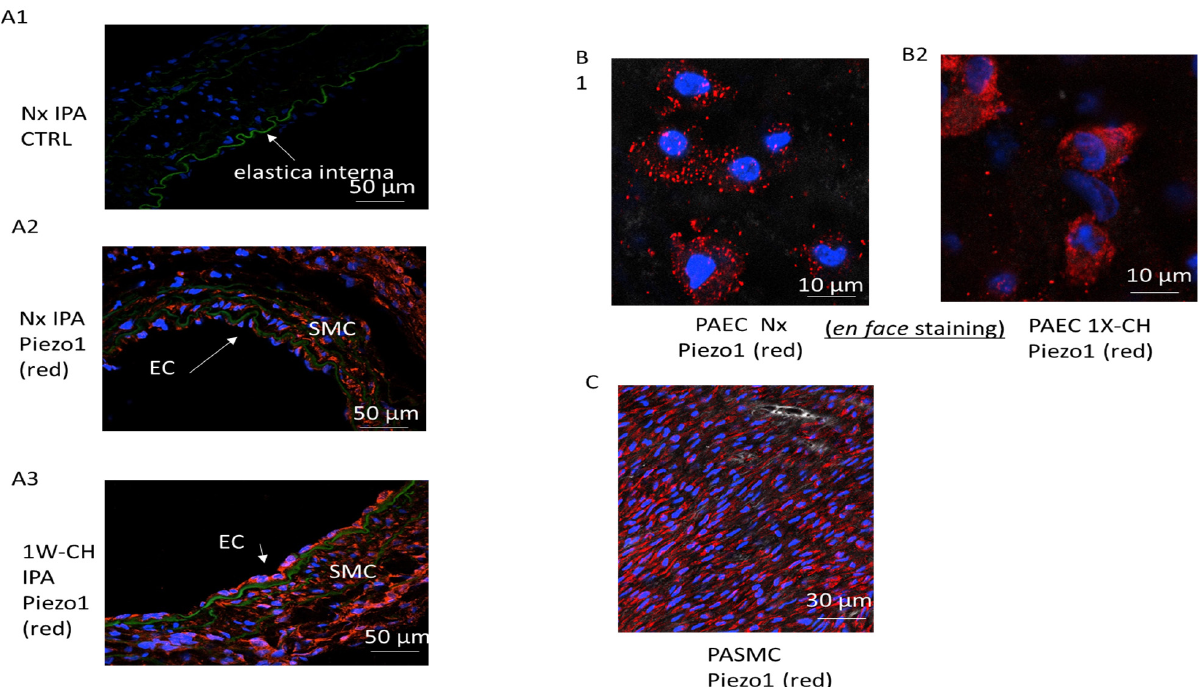
Figure 2. Piezo1 channels are expressed in PAECs and PASMCs in an early stage of CH-PH. PASMCs and PAECs expressed Piezo1 channels. ( A ) Immunostaining on thin transversal section: the endothelial layer (EC) and the media (smooth muscle cell, SMC) of IPA expressed Piezo1 ( A1 ) without primary antibody, ( A2 ) Nx IPA, ( A3 ) 1W-CH IPA; elastic lamina in green separates media from intima. ( B ) PAECs were observed in the en face configuration in ( B1 ) Nx IPA or ( B2 ) 1W-CH IPA. ( C ) PASMCs were observed in the en face configuration in Nx IPA; note that SMC nuclei had a characteristic shape (elongated) as compared to EC nuclei. Red = antibody against Piezo1; blue = nucleus.